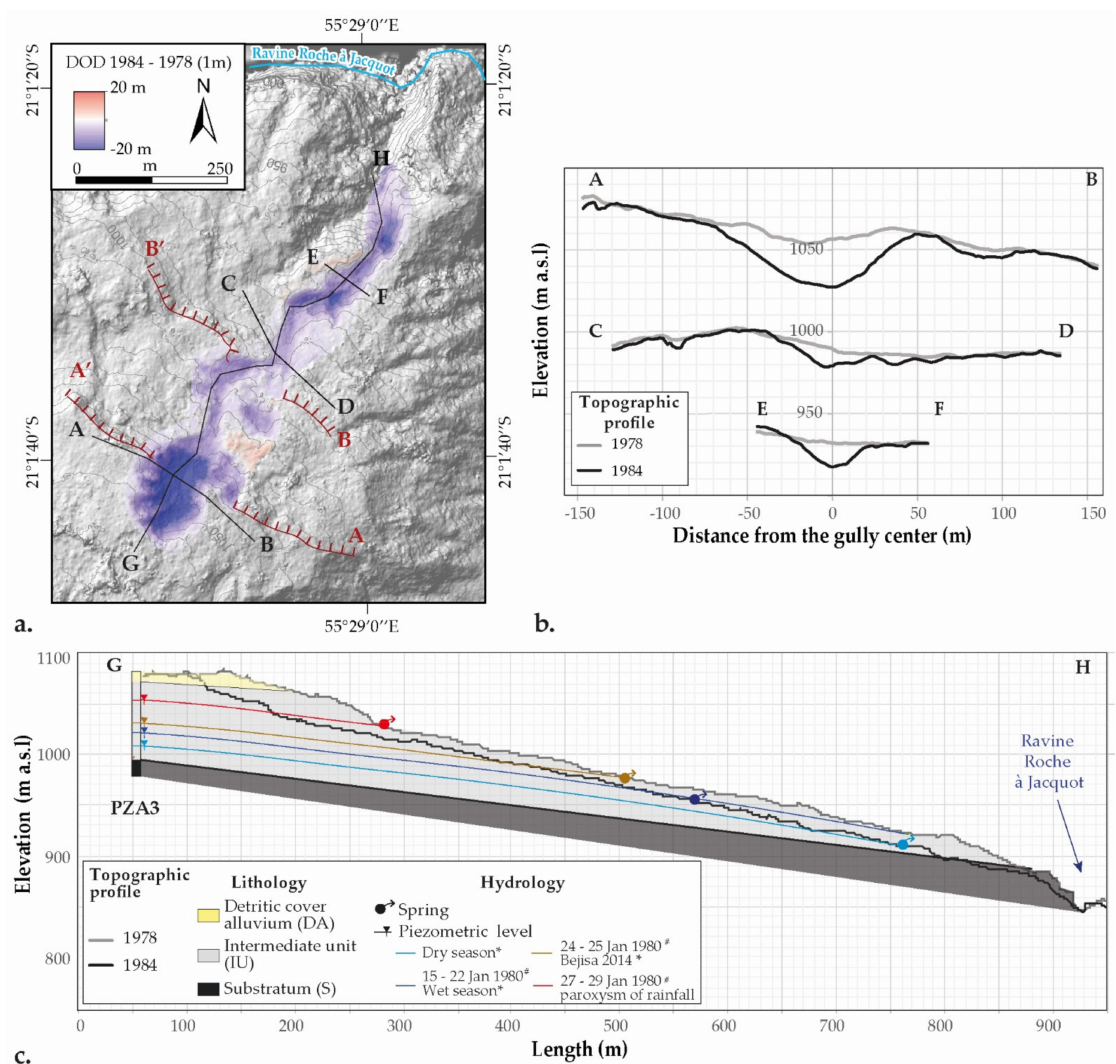
Figure 5. Comparison of the 1978 and 1984 topographies in the Ravine de l’Eglise watershed ( a ) 1 × 1 m DEM of Difference (DoD) comparing 1978 DSM and 1984 DSM calculated above the gully of the Ravine de l’Eglise. Deep blue indicates major surface excavation. The black lines A-B, C-D and E-F mark the ends of the transversal topographic profiles presented in ( b ) and G-F the longitudinal topographic profile presented in ( c ). The red lines A-A’ and B-B’ are the Grand Ilet scarps imaged in Figure 2. Light-grey lines are the 10 m elevation contours. ( b ) Transversal profiles of the gully. ( c ) Longitudinal profile of the gully with the measured and hindcast groundwater levels (see next section). # : piezometric level hindcast for Cyclone Hyacinthe, *: piezometric level